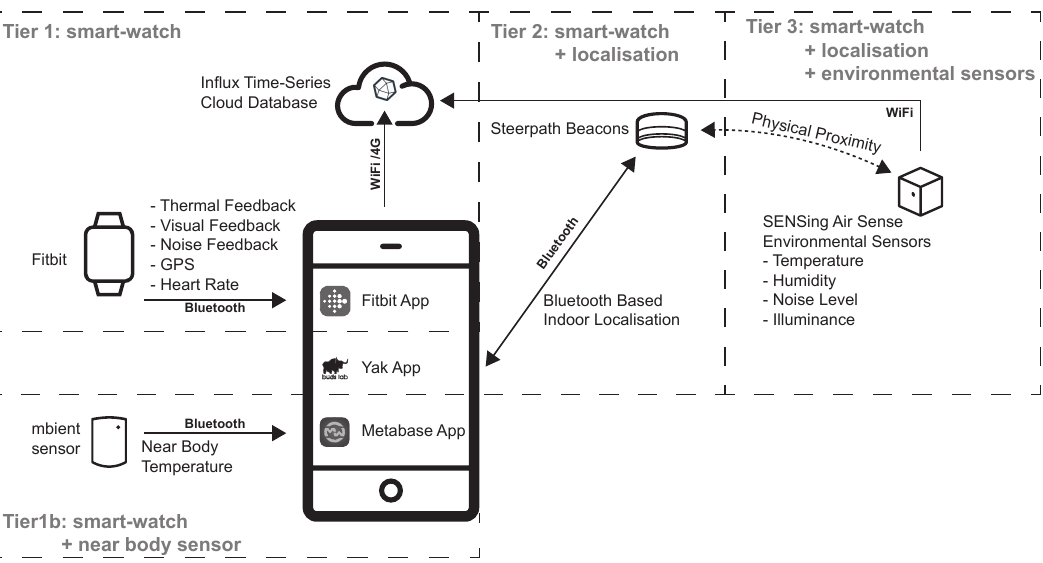
Figure 3. Overview of the experimental deployment in the NUS SDE buildings in four distinct tiers: Tier 1 is the base methodology which is production-ready for real-building deployment. It requires a smart watch with the cozie clock-face installed. Tier 1b, is an extension to the base methodology by adding a temperature sensor to the watch. Tier 2 includes building-wide indoor